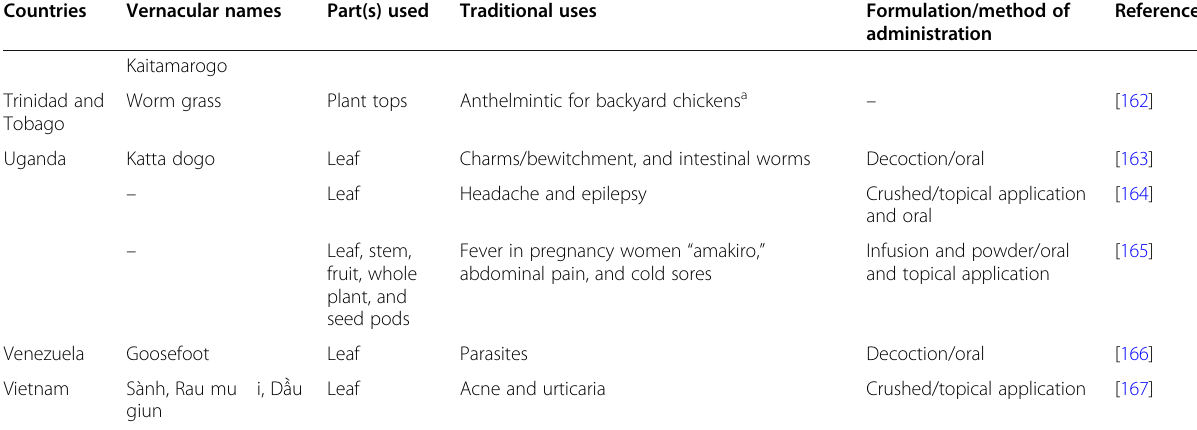
Table 1 Traditional uses of the different parts of C. ambrosioides worldwide